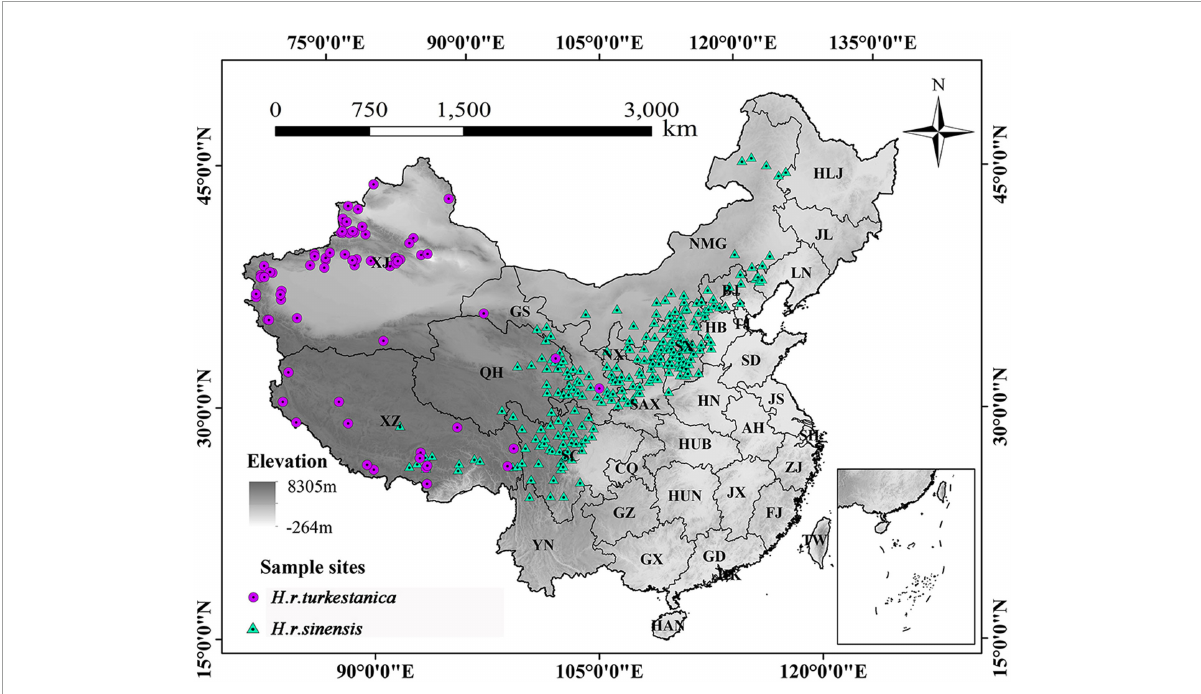
FIGURE1 Sample sites of H. r. sinensis and H. r. turkestanica populations in China. Provinces names are abbreviated, XJ, Xinjiang; XZ, Xizang (Tibet); QH, Qinghai; GS, Gansu; NX, Ningxia; NMG, Inner Mongolia; SC, Sichuan; CQ, Chongqing; SAX, Shaanxi; SX, Shanxi; HN, Henan; HUB, Hubei; HUN, Hunan; SD, Shandong; BJ, Beijing; TJ, Tianjin; LN, Liaoning; HB, Hebei; JS, Jiangsu; AH, Anhui; ZJ, Zhejiang; GX, Guangxi; GD, Guangdong; YN, Yunnan; JX, Jiangxi; FJ, Fujian; GZ, Guizhou; SH, Shanghai; HLJ, Heilongjiang; JL, Jilin; HAN, Hainan; MAC, Maco; HK, Hongkong; and TW,